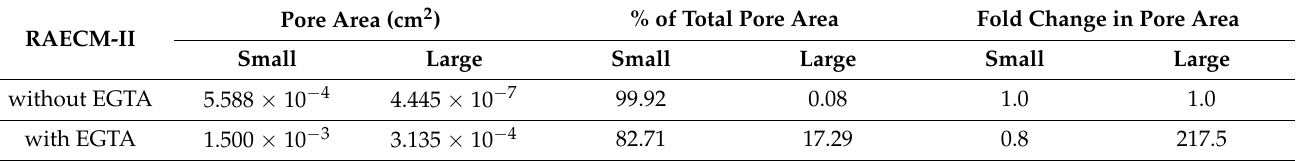
Table 7. Small and large equivalent pore areas and their fractions and fold changes in equivalent pore area in response to EGTA treatment of RAECM-II. Entries are based on the estimated values listed in Table 6. Equivalent pore area is per nominal surface area (1 cm 2 ) of